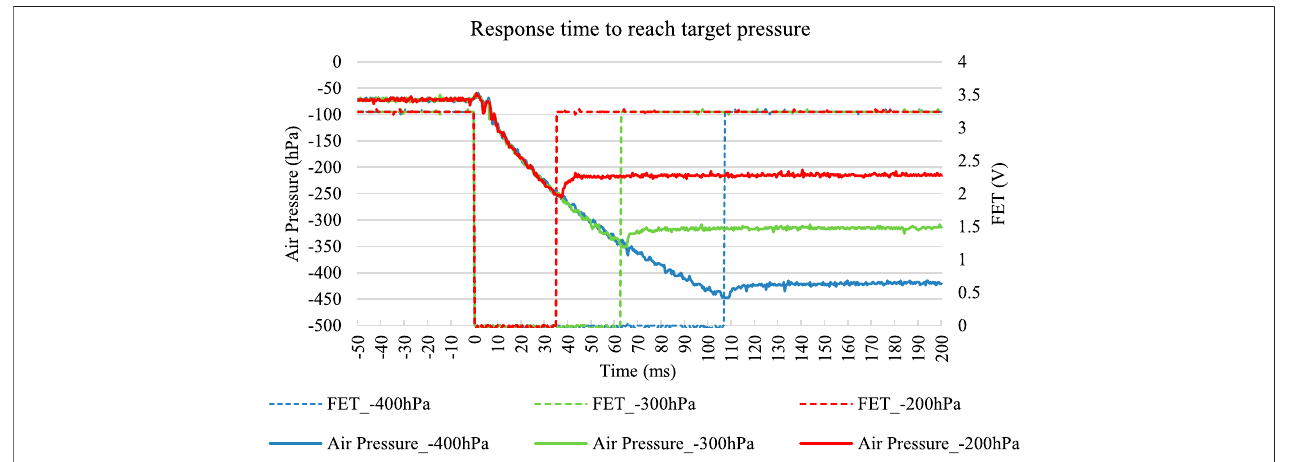
FIGURE 3 | Response time to reach target pressure ( − 200, − 300, and − 400 hPa) and FET gate voltage. The suction start time was set to 0 ms.